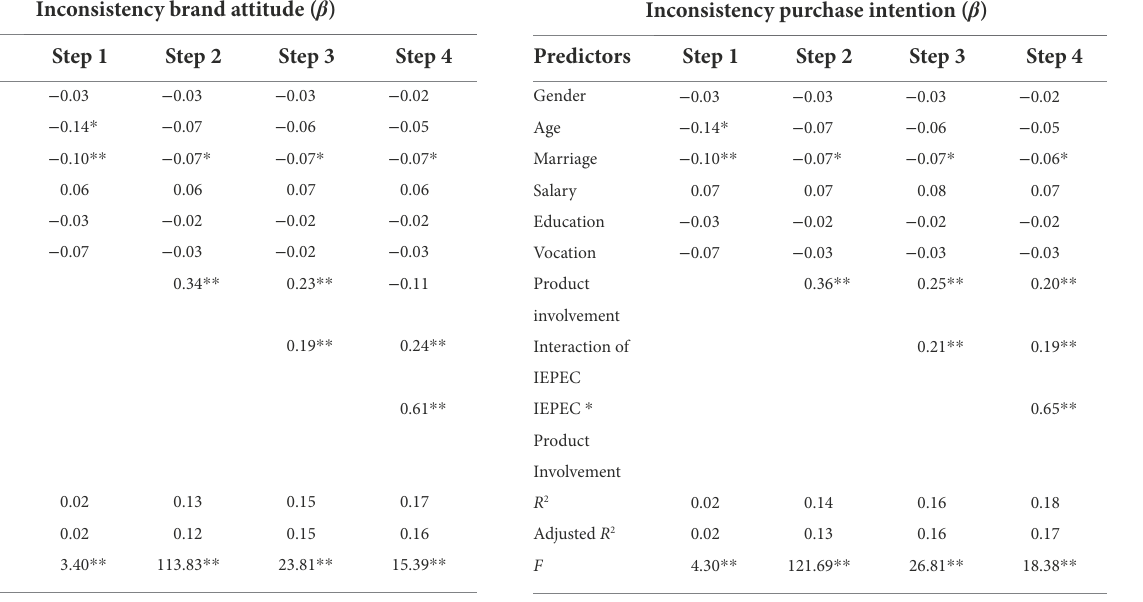
TABLE 7 Results of product involvement as a moderating role between virtual anime endorser-product incongruence and attitude toward the brand.